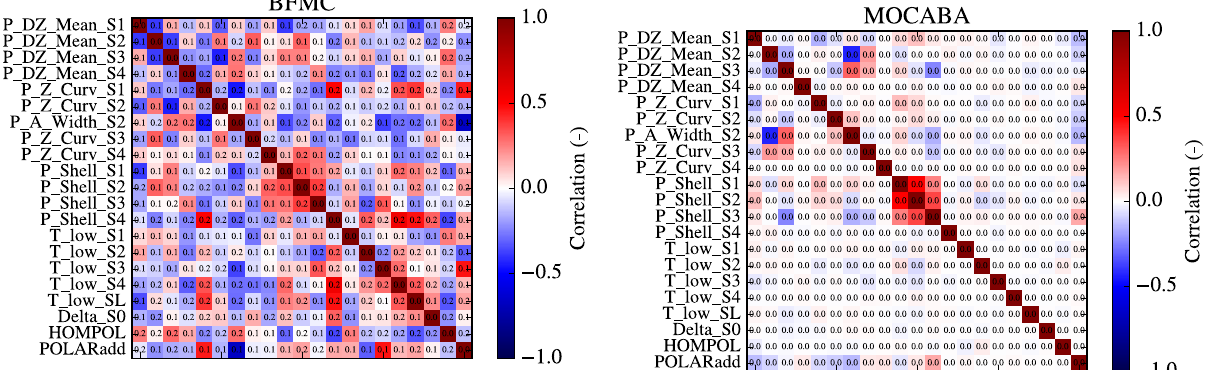
Fig. 4. Skewness and p -values from a Shapiro-Wilks normality test for the prior calculated FP concentrations of fuel sample U1.